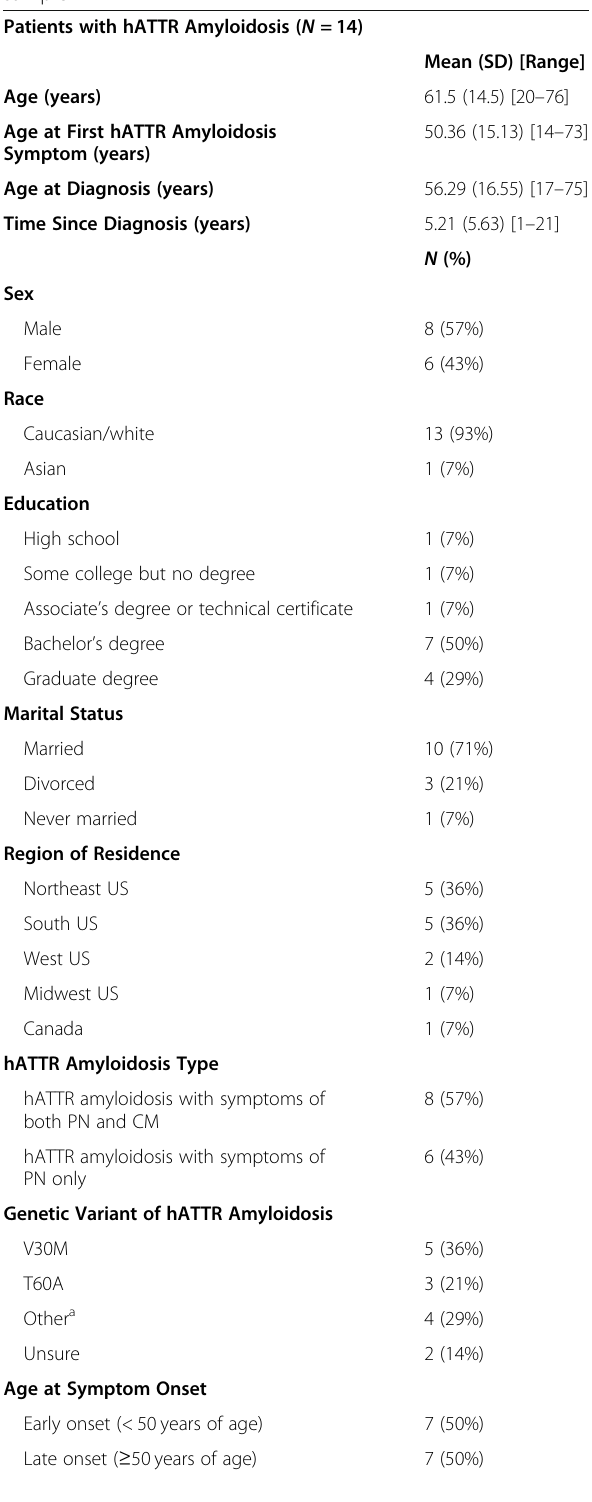
Table 2 Demographic and disease characteristics of study sample